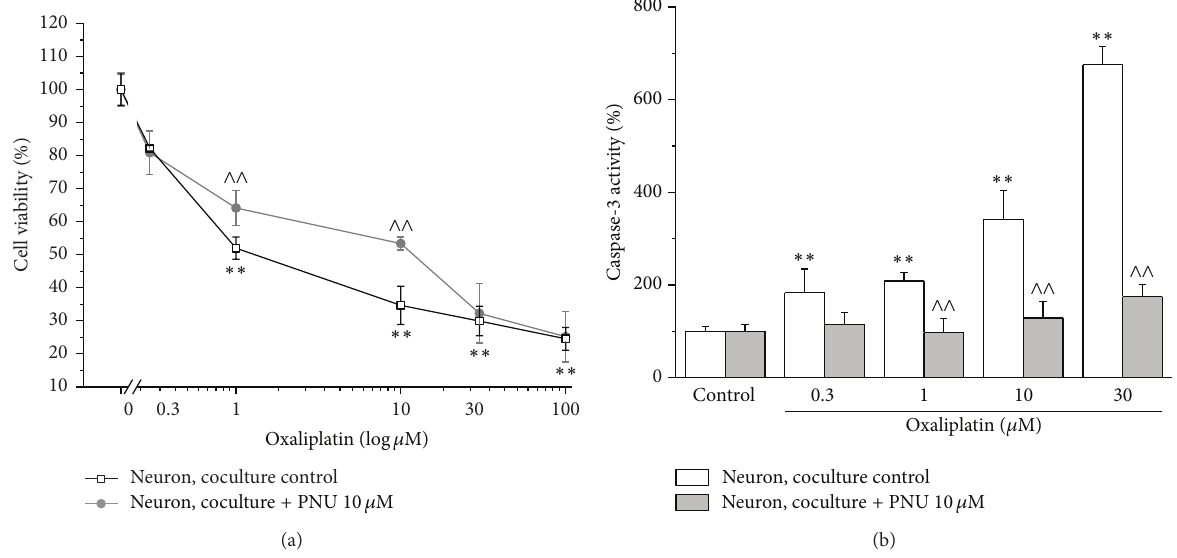
Figure 2: Effect of PNU in cocultures. (a) Cell viability. Neuron astrocyte coculture (2 10 5 neurons/well and 8 10 4 astrocytes/well) was incubated with oxaliplatin (0.3–100 𝜇 M) in the absence or presence of 10 𝜇 M PNU for 48 h. Neuronal cell viability was quantified by MTT assay. Values are expressed in percentage of control absorbance as mean ± S.E.M. of 6 experiments. Control condition absorbance was fixed to 100%. ∗∗ 𝑃 < 0.01 versus control; ∧∧ 𝑃 < 0.01 versus oxaliplatin treatment. (b) Caspase-3 activity. Neuron astrocyte coculture (7 10 5